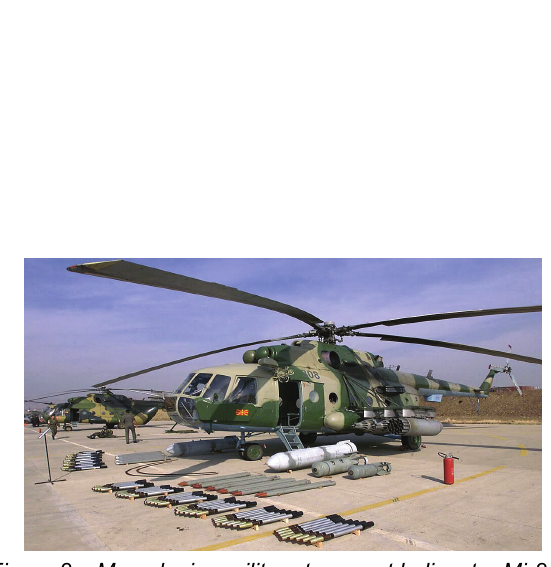
Figure 8 – Macedonian military-transport helicopter Mi-8/17 Рис . 8 – Македонский военно - транспортный вертолет Ми -8/17 Слика 8 – Македонски војни транспортни хеликоптер Ми